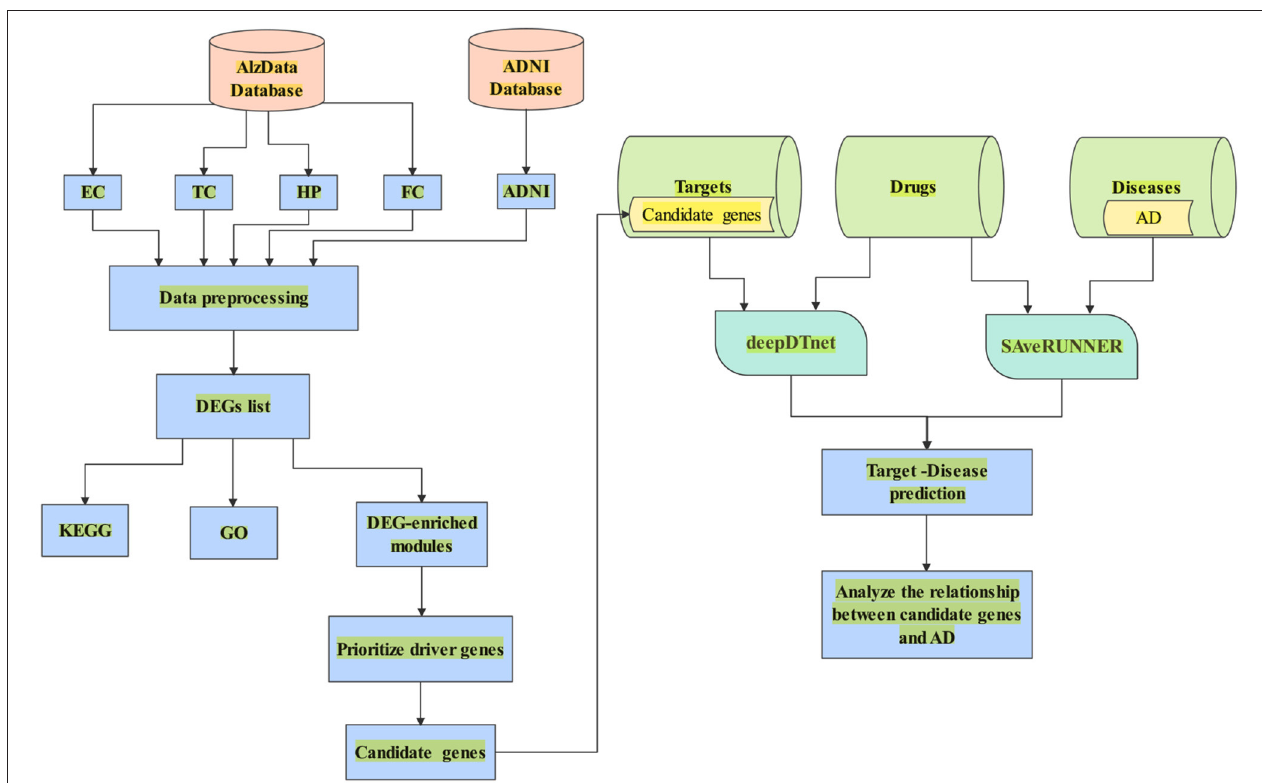
FIGURE 1 | A flowchart of the whole study. (1) Data collection from AlzData and ADNI; (2) Data preprocessing (e.g., eliminating the samples with missing data); (3) DEGs regarded with | logFC | > 0.1 and FDR < 0.05; (4) Enrichment of biological process analyzed by DAVID 6.8; (5) Use WGCNA to find AD-specific module; (6) Prioritize driver genes of AD by CFG score; (7) candidate genes with CFG ≥ 5 are identified. (8) Collect the dataset of target, drug and disease; (9) Combine deepDTnet and SAveRUNNER to predict association between candidate genes and